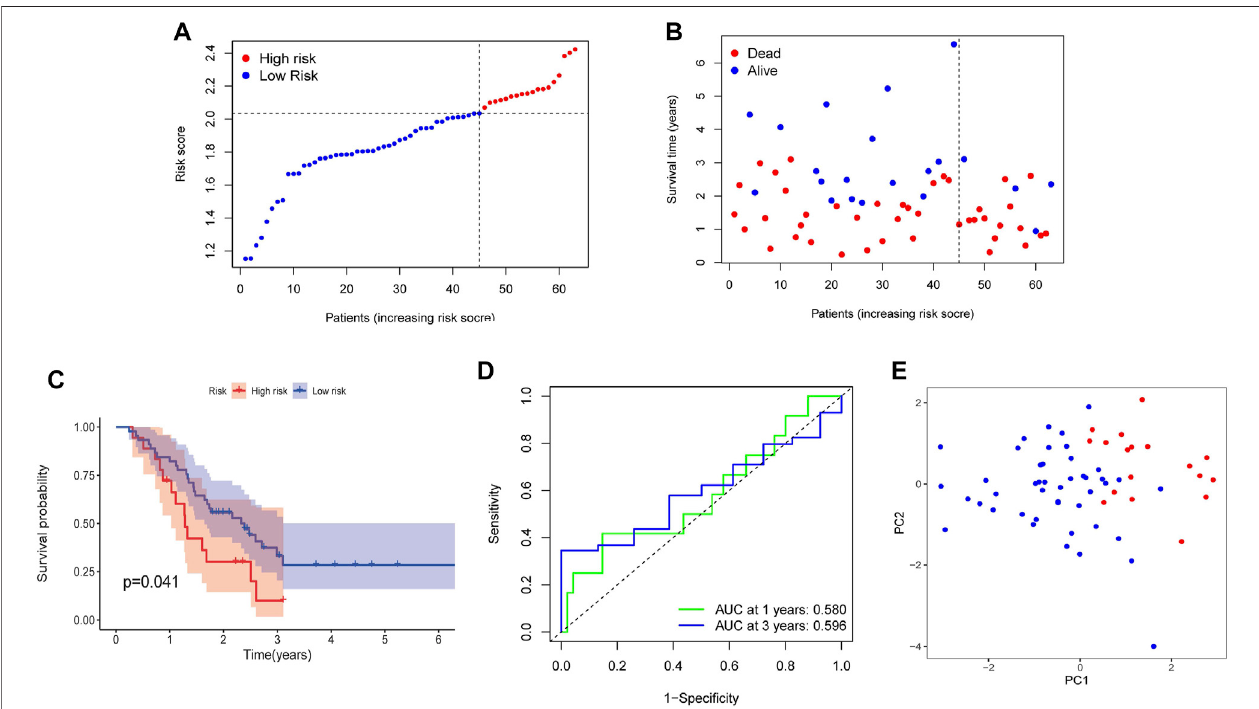
FIGURE7| ValidationoftheprognosticriskmodelintheGEOcohort. (A) Distributionofriskscore. (B) Thesurvivalstatusandsurvivaltimedistribution. (C) Kaplan- Meier survival analysis between the high-risk group and the low-risk group. (D) Time-dependent ROC curve to verify the ef fi ciency of the model. (E) Results of PCA